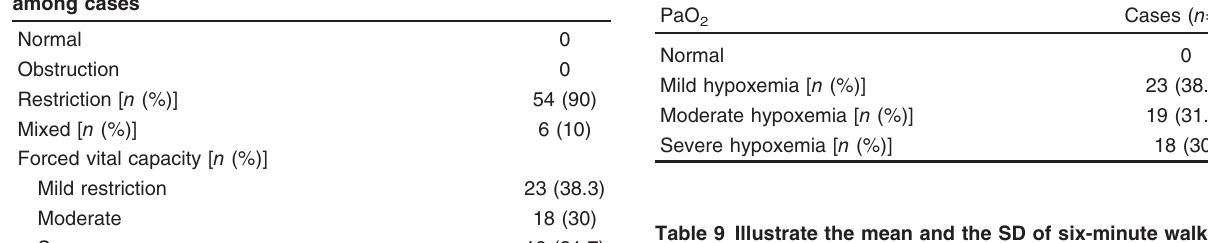
Table 9 Illustrate the mean and the SD of six-minute walk test and pulmonary artery systolic pressure